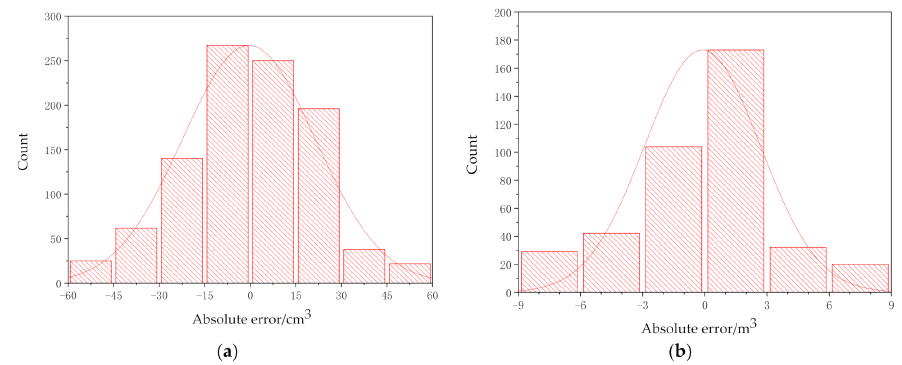
Figure 10. Error distribution histogramt: ( a ) Data in a laboratory environment; ( b ) Data in an open- pit mine.